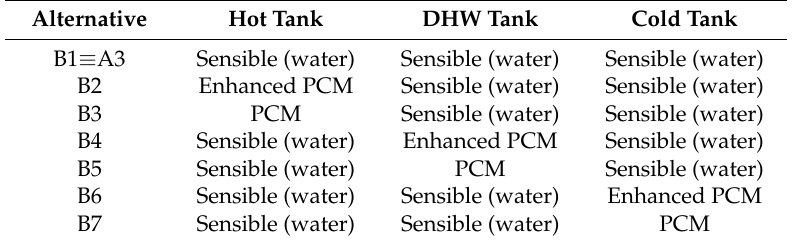
Table 5. Alternatives (all based on alternative A3 in Table 7) simulated with different storage tank configurations.